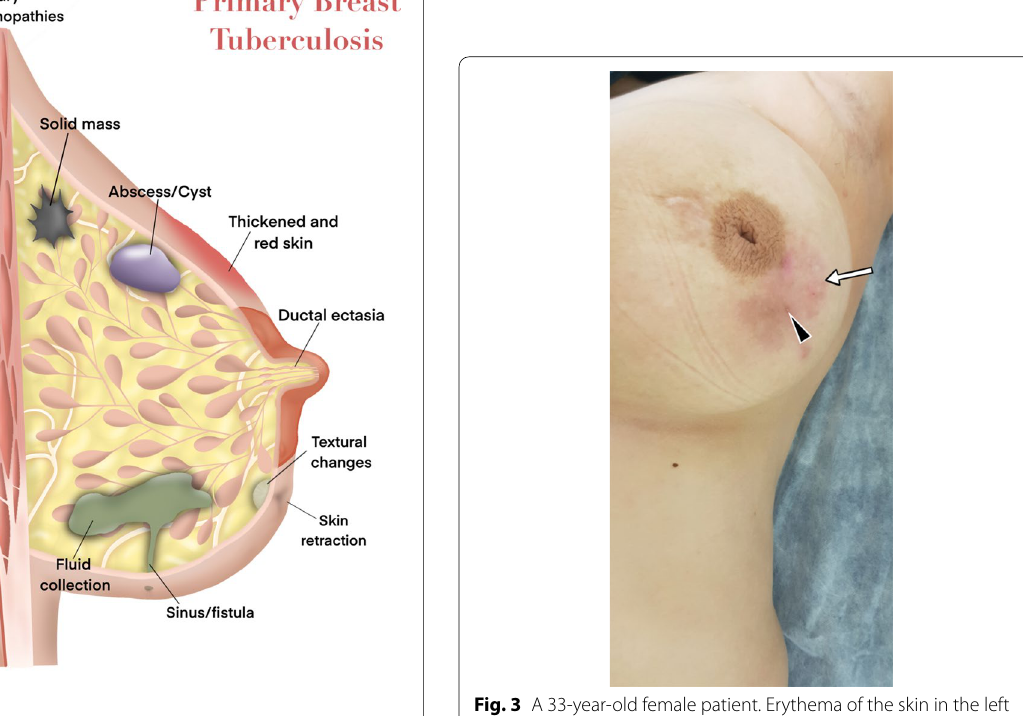
Fig. 1 Breast anatomy and the effects of tuberculosis